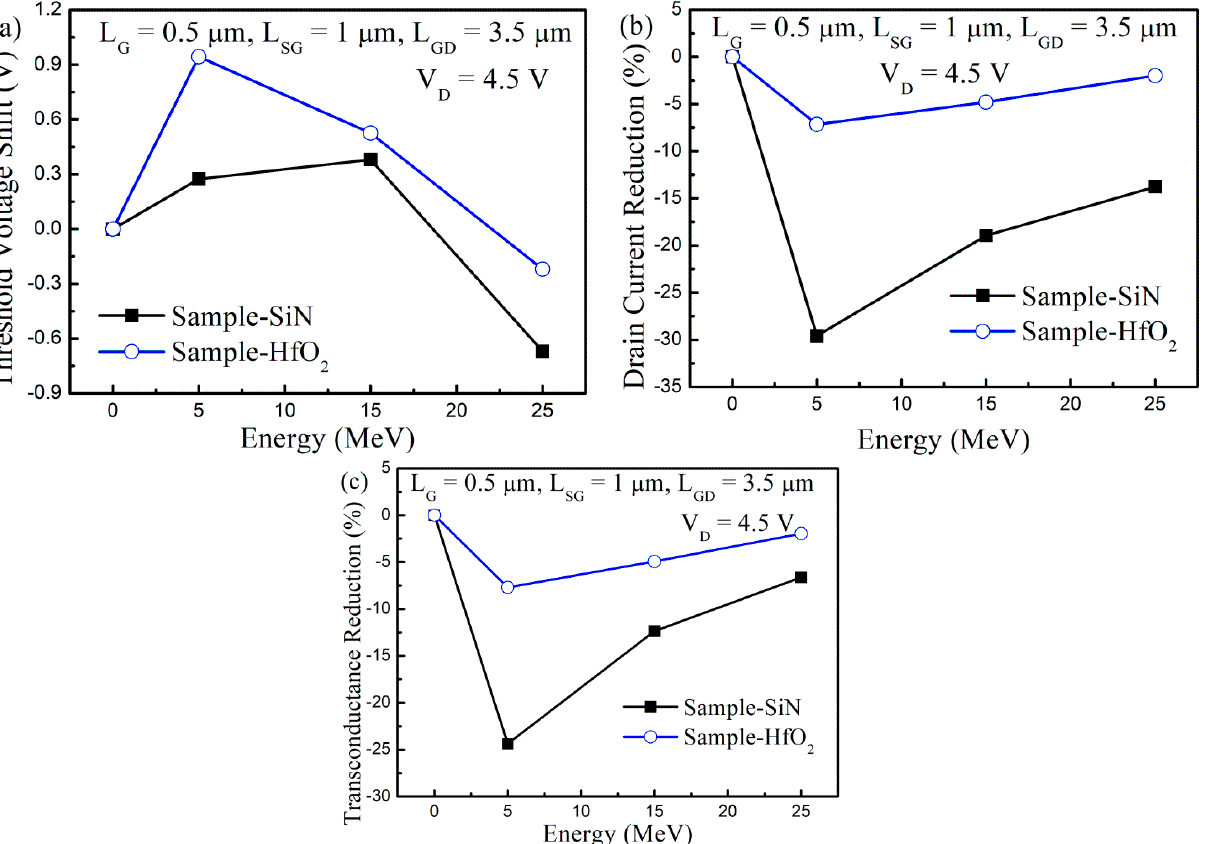
Figure 3. Device parameter extraction before and after proton irradiation in GaN-based MIS-HEMTs for the 5 nm-thick Si 3 N 4 and HfO 2 gate insulator. ( a ) Threshold voltage shift; ( b ) transconductance maximum reduction; ( c ) drain current reduction as a function of the proton irradiation energy.